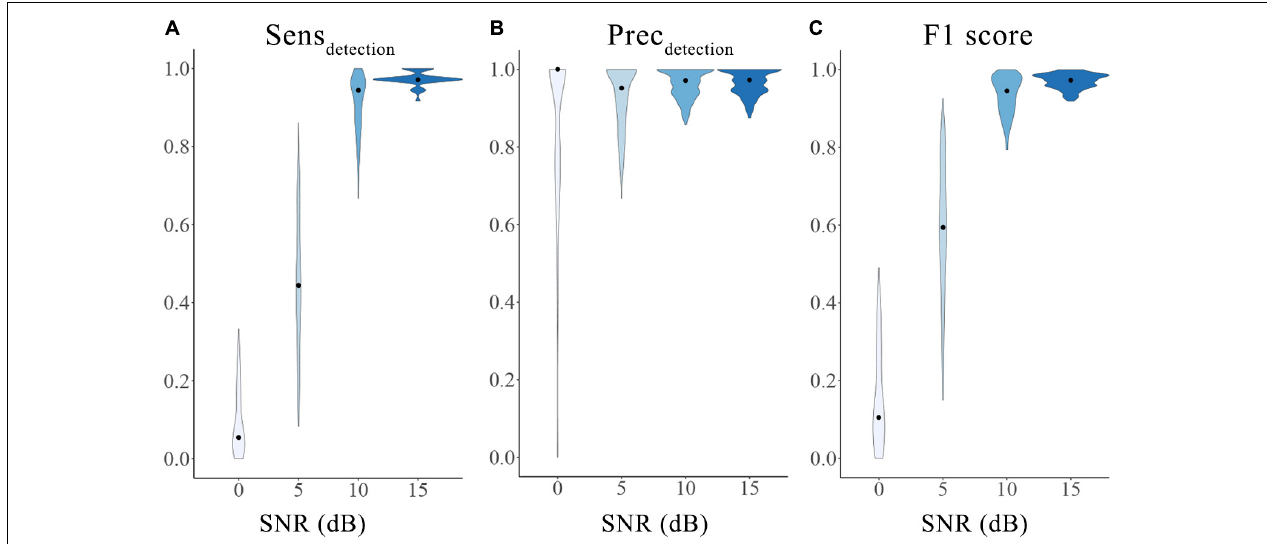
FIGURE 2 | Performance of the initial detector tested on an open simulation dataset. The three metrics were calculated as sensitivity (A) , precision (B) and F1 score (C) for different SNRs. The violin plots show the range (minimum to maximum) and distribution of the data. The black dots represent the median values. Different color indicates different SNRs groups. SNRs: signal-to-noise ratios; Sens detection : sensitivity of the initial detection; Prec detection : precision of the initial detection.